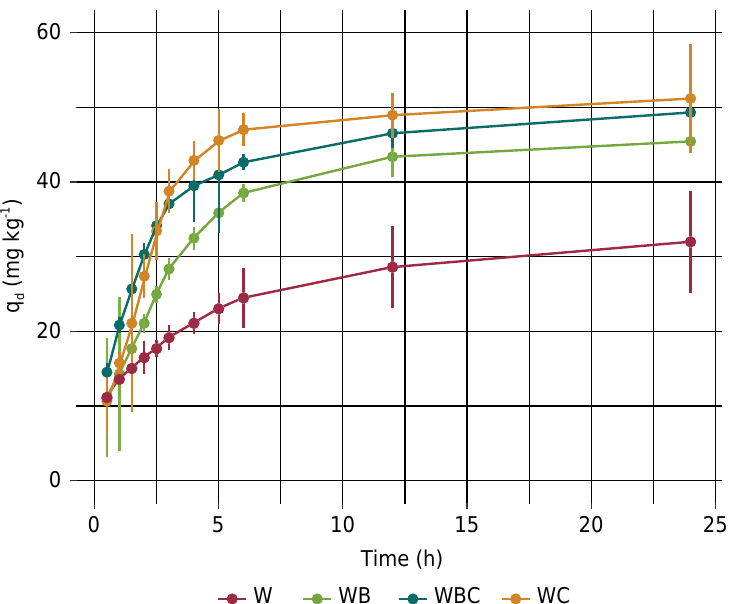
Figure 3. Cumulative P desorption (q d ) as a function of contact time in Fe mining waste (W) enriched with organic compost (WC), biochar (WB), and a combination of both amendments (WBC).